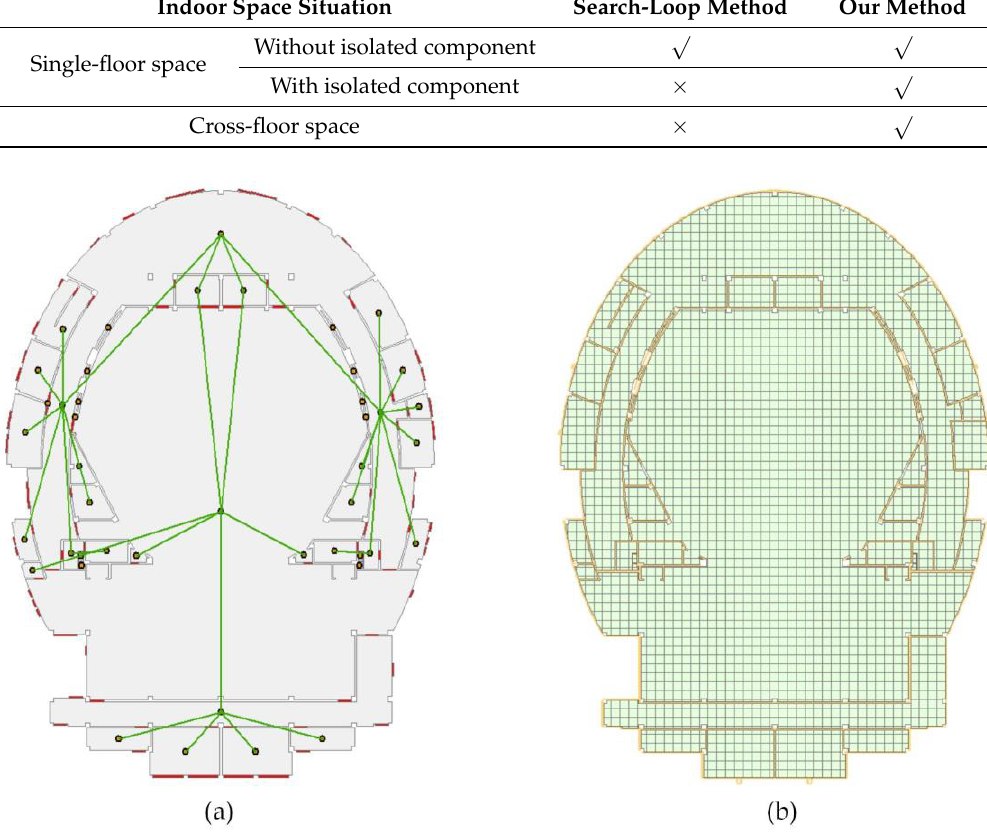
Figure 25. Conversion to other indoor space expression models: ( a ) network and ( b ) grid model.